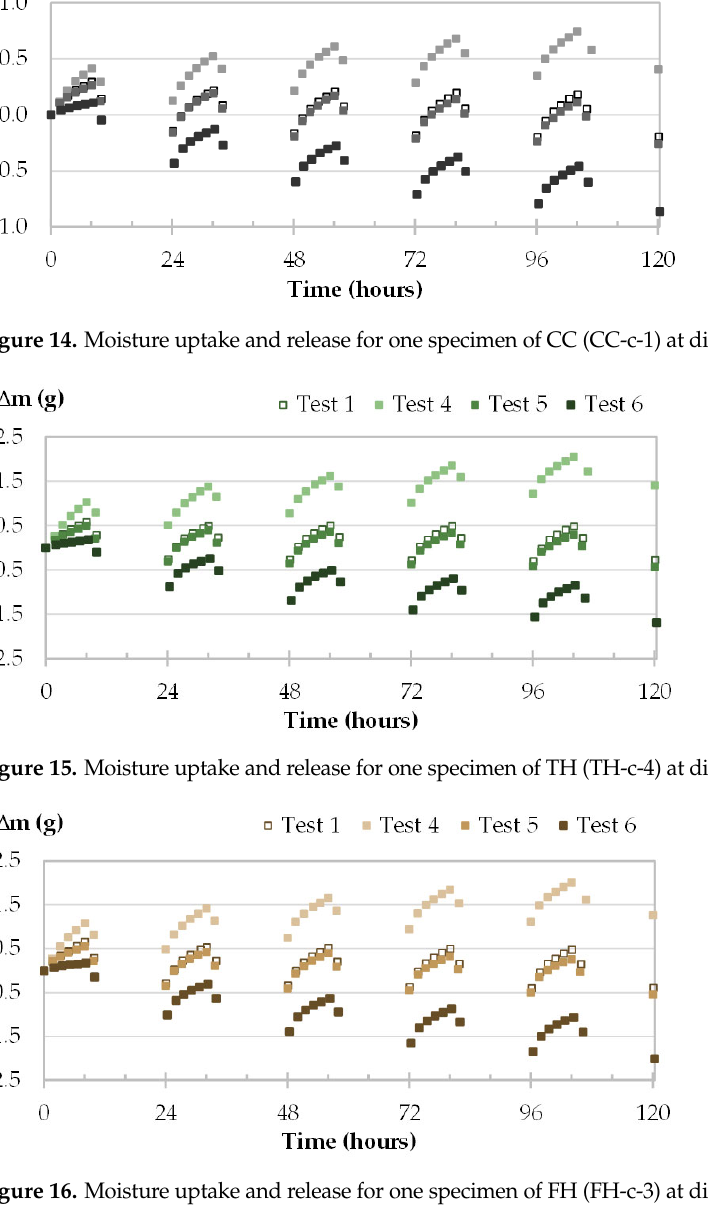
Figure 16. Moisture uptake and release for one specimen of FH (FH-c-3) at different initial condi- tioning.